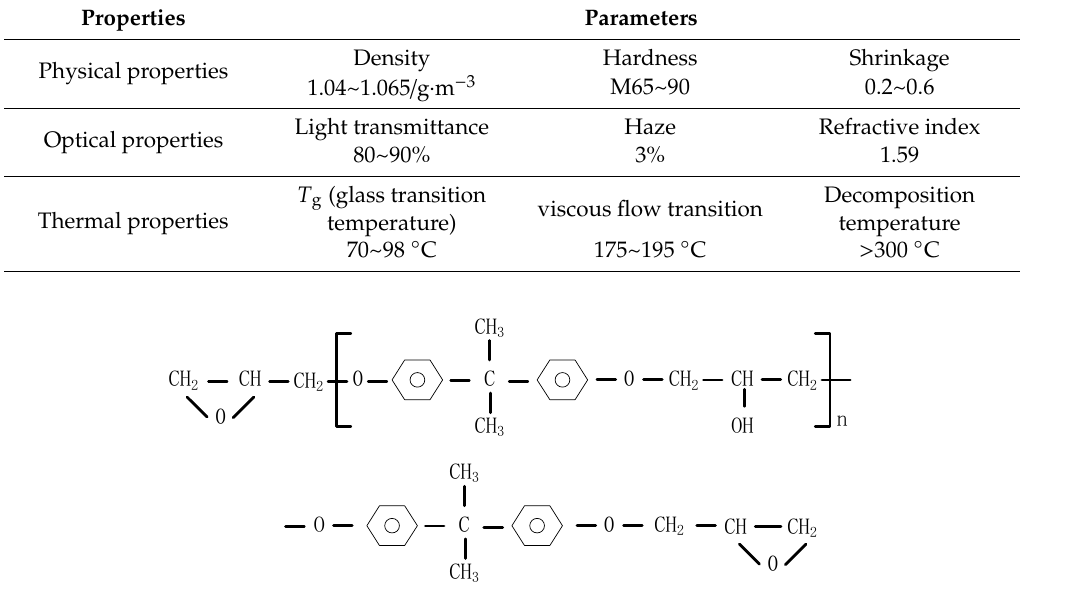
Figure 1. Chemical structure of CYD-128.